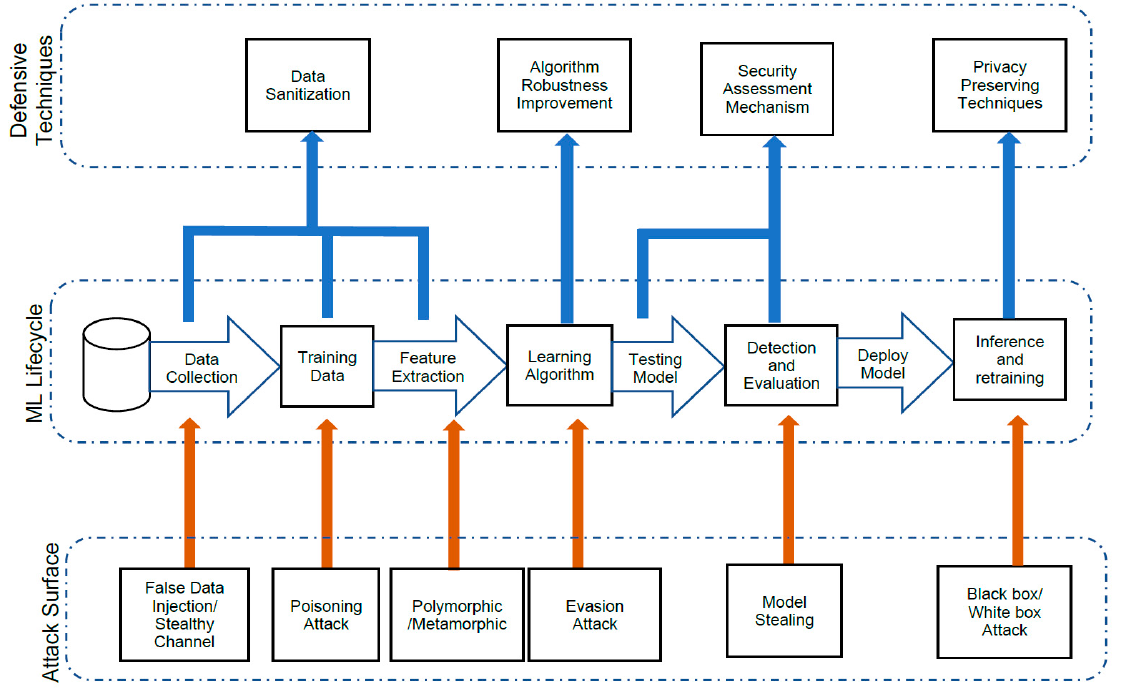
Figure 3. Threat model of the machine learning process.